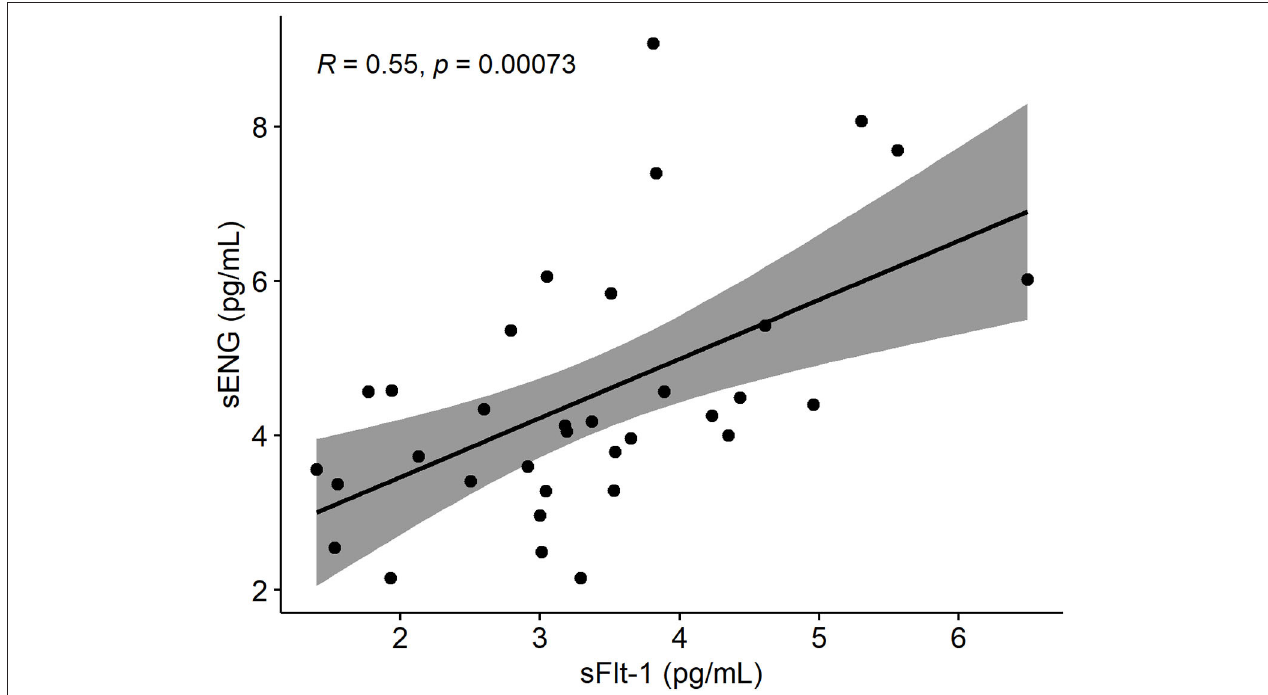
FIGURE 4 | Spearman’s rank correlation plot between sENG and sFlt-1 measurements of sera drawn from pregnant women within 70 and 98 gestational days. Gray around the linear regression line (y = 0.7651x + 1,931.4) indicates the 95% confidence region. sENG, soluble endoglin; sFlt-1, soluble fms-like tyrosine kinase-1.